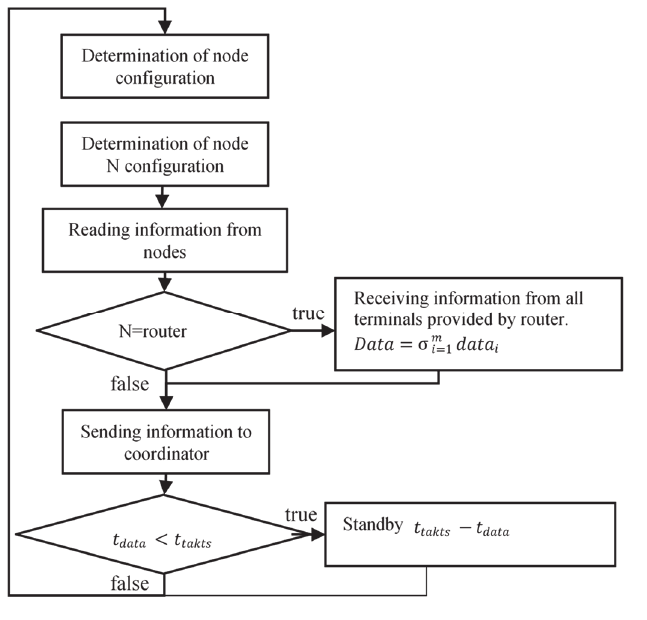
Fig. 1. The alternative operating algorithm of the network